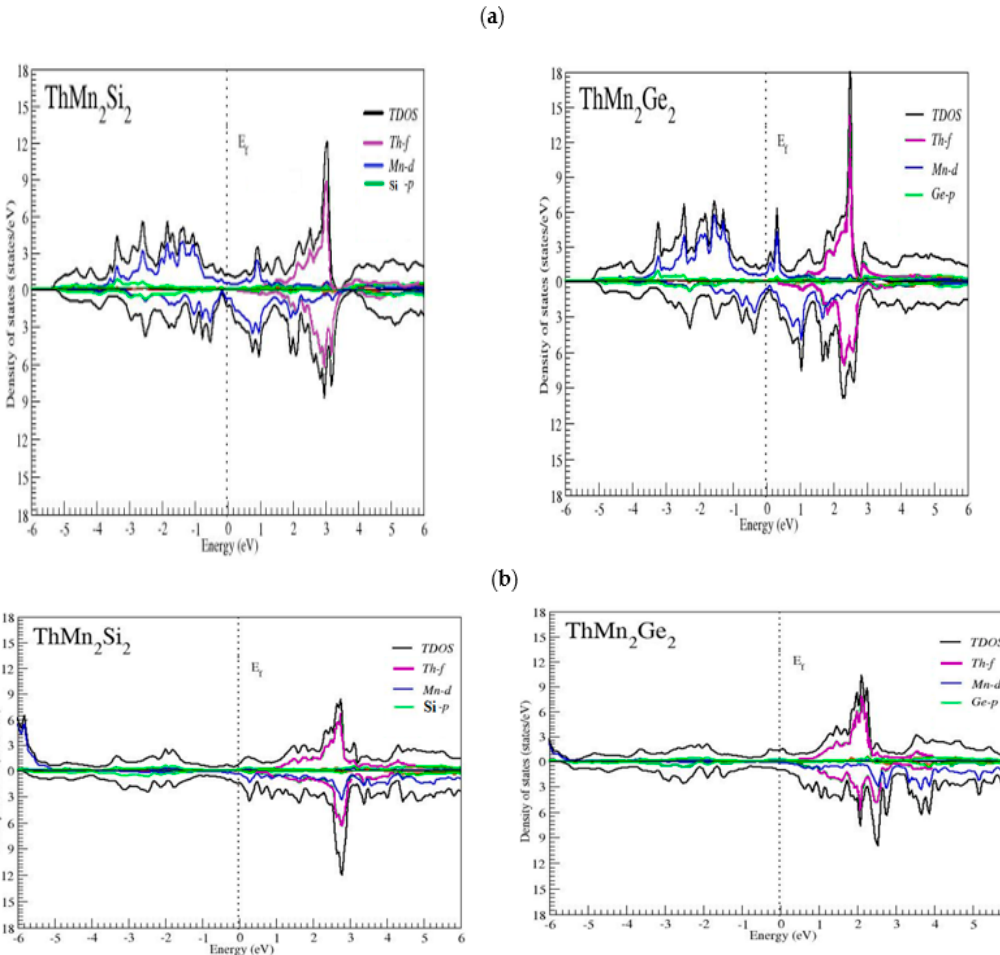
Figure 3. ( a ) Plotted DOS of ThMn 2 Si 2 and ThMn 2 Ge 2 compounds in body-centered tetragonal fer- romagnetic phase, using GGA in both orientations; ( b ) plotted DOS of ThMn 2 Si 2 and ThMn 2 Ge 2 compounds in body-centered tetragonal ferromagnetic phase, using GGA + U in both